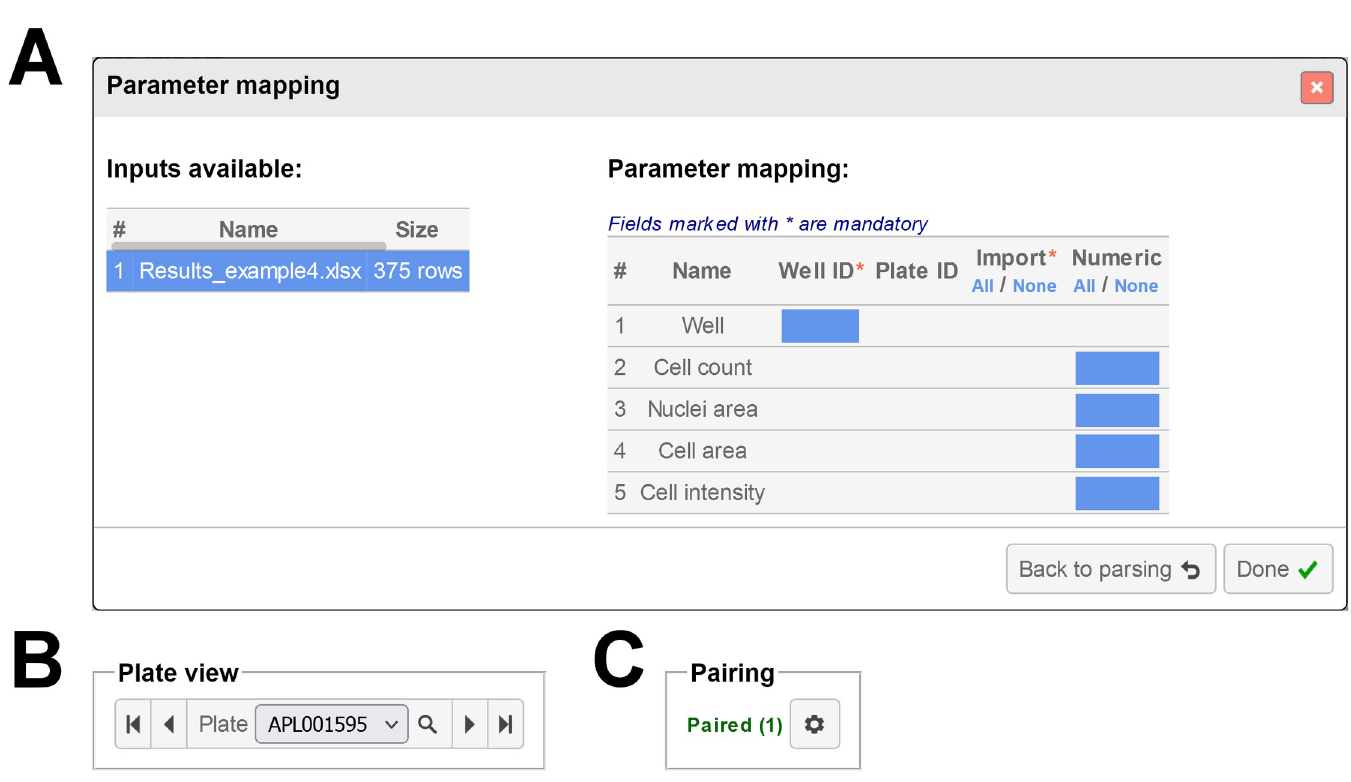
Fig 2. Parameter mapping, plate view and pairing. A . Overview of the parameter mapping process for a result file including 5 columns (Well, Cell count, Nuclei area, Cell area, Cell intensity). Any column name including the keyword “well” is automatically assigned to the Well ID parameter. An optional Plate ID parameter can also be mapped when relevant (multiple plates per file). At least one column should be mapped as a parameter ( Import ); the values for this column will be displayed as heatmap under the Data panel of PlateEditor . The first row of data is used to automatically determine if the values are numerical or textual, but the user can adjust this setting manually ( Numeric ). B . The Plate View control allows selection of the plate name or plate index to display for the result file currently selected. Description of the controls, from left to right: display the first plate available; display previous plate; selection of a plate directly from the drop-down list; lookup tool to search specific plate names; display the next plate; display the last plate available. C . Pairing indicates whether the selected result plate is paired with one or more definition plates. Pairing options can be adjusted by clicking the gear icon.